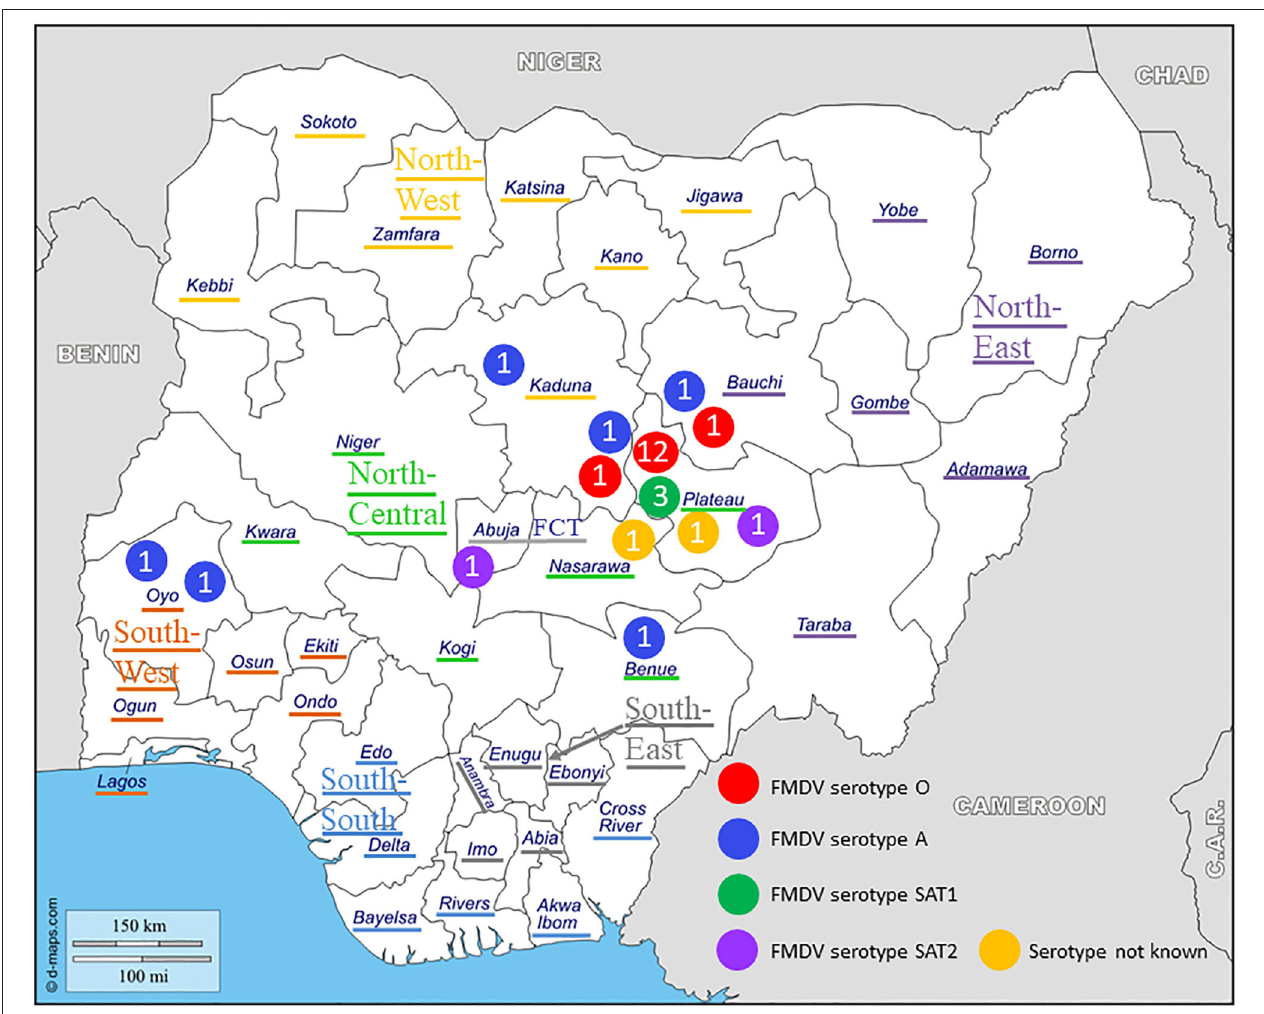
FIGURE 1 | Geographical distribution and serotypes of foot-and-mouth disease virus (FMDV) isolates collected in Nigeria between 2012 and 2017. The geopolitical zones and the Federal Capital Territory (FCT) are